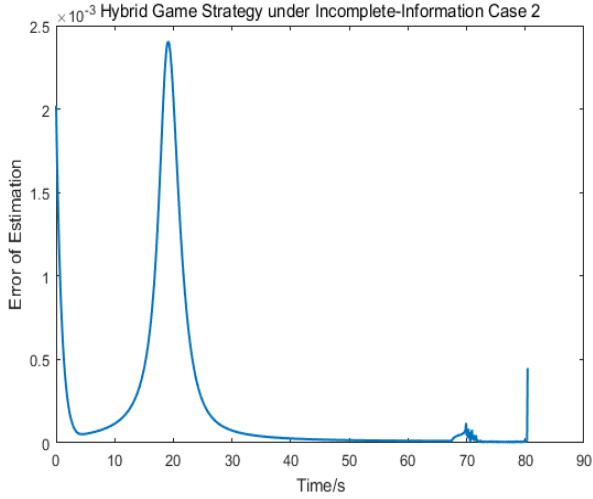
Figure 14. Error estimation of U E